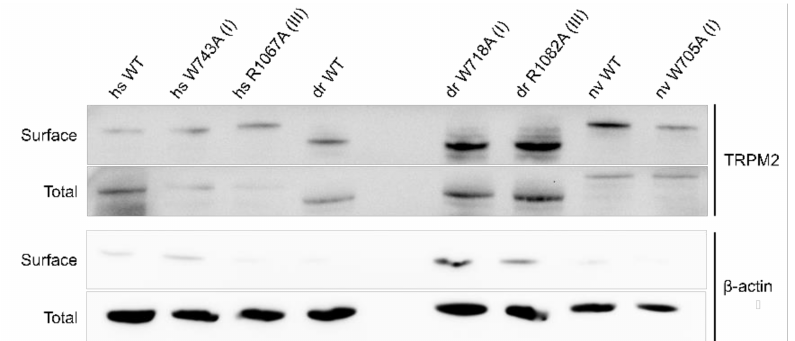
Figure 6. Biotinylation assay of TRPM2 expressed in HEK-293 cells. Representative surface and total expression of hs-, dr- and nvTRPM2 WT and point mutations via biotinylation. β -actin was used as the loading control.